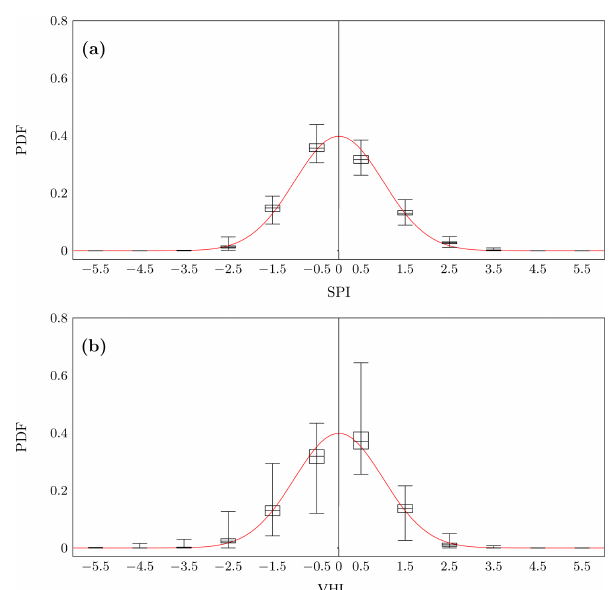
Figure 4. (a) Distribution of SPI values and (b) distribution of VHI st values. The red lines represent the PDFs of the standard nor- mal distributions; boxplots represent the percentage of values lying within the range; 12 ranges were considered, starting from − 6 and ending with 6 with a step equal to